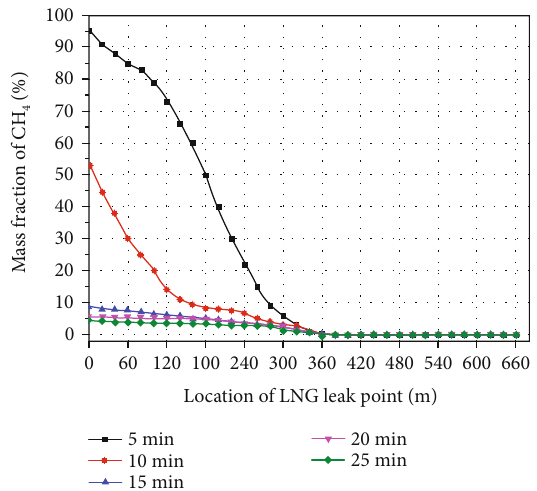
Figure 15: E ff ect of LNG leak location on CH